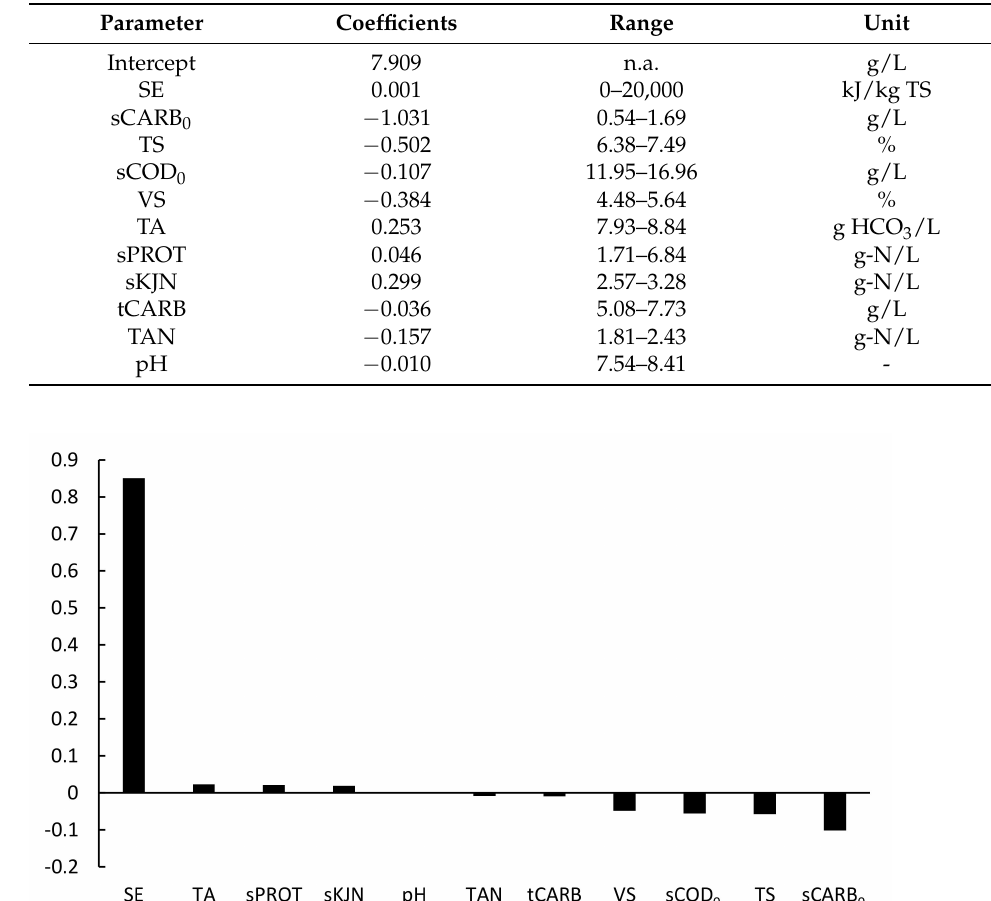
Figure 5. Standardized regression coefficients, in decreasing order, for the selected model pre- dicting the sCOD after ultrasonication of digestates, constructed using partial least squares (PLS) methodology using two latent